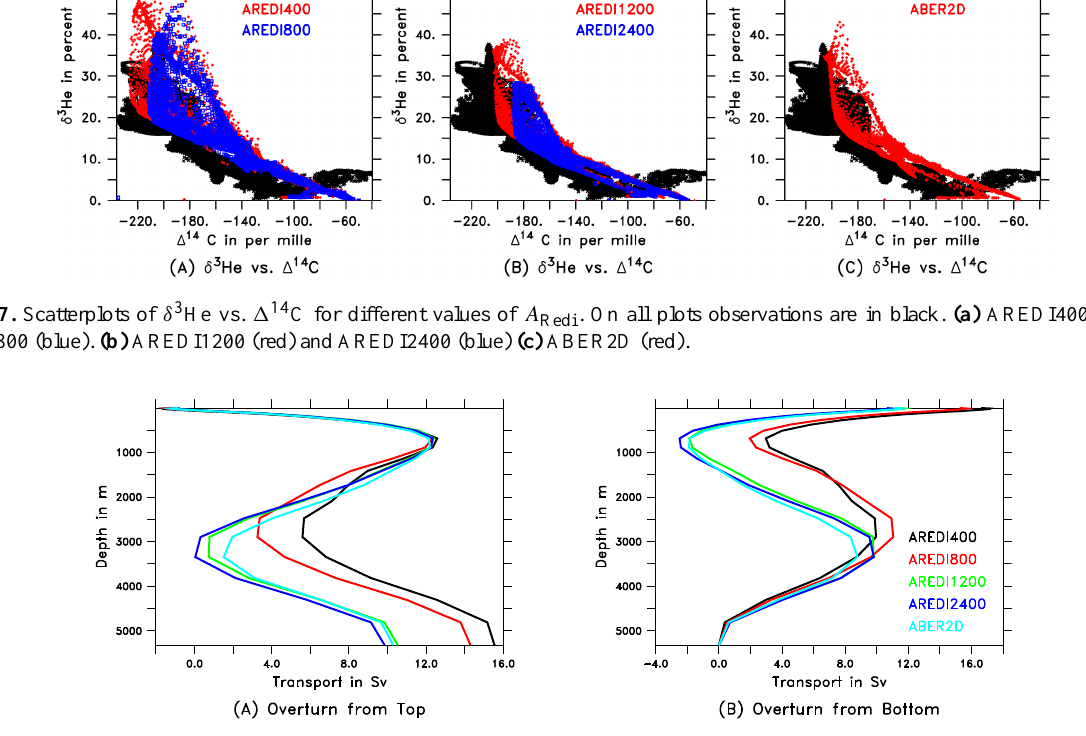
Figure 8. Overturning in the South Pacific at a latitude of 30 ◦ S across the different model runs. Overturning is computed as a running sum of northward transport. (a) Overturning summed from top to bottom, emphasizing similarity in northward surface flow. (b) Overturning summed from bottom to top, emphasizing similarity in deep inflow of Antarctic Bottom